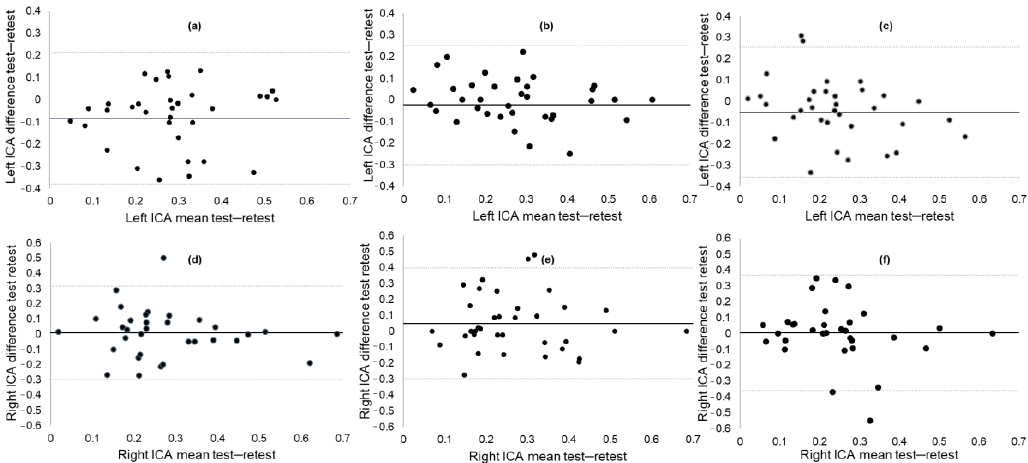
Figure 2. Bland–Altman plots of ( a ) the left eye 0-back ICA mean; ( b ) the left eye 1-back ICA mean; ( c ) the left eye 2-back ICA mean; ( d ) the right eye 0-back ICA mean; ( e ) the right eye 1-back ICA mean; and ( f ) the right eye 2-back ICA mean. ICA, Index of Cognitive Activity. The ICC values were similar across groups, except for the 0-back and 2-back left ICA means, which were substantially lower in the MCI/AD groups compared to the Aβ− and Aβ+ groups (Supplementary Table S1). The ICC values ranged between 0.60 (2-back right ICA mean) and 0.80 (0- back right mean ICA) for the Aβ− group; 0.42 (1-back right ICA mean) and 0.88 (1-back left ICA mean) for the Aβ+ group; and −2.44 (2-back left ICA mean) and 0.91 (1-back right ICA mean) for the MCI/AD group.